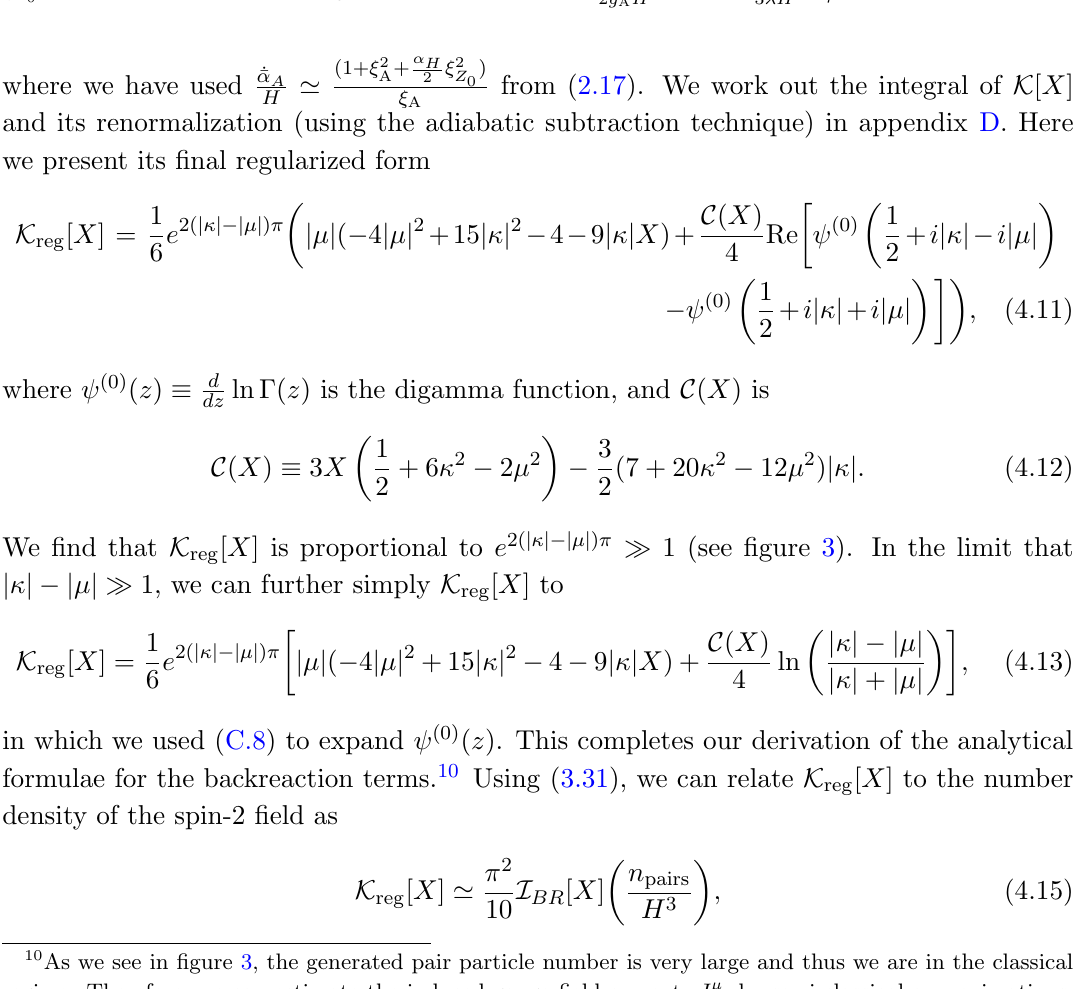
J A and f P ’ 2 g A H 3 3 (cid:21)H 4